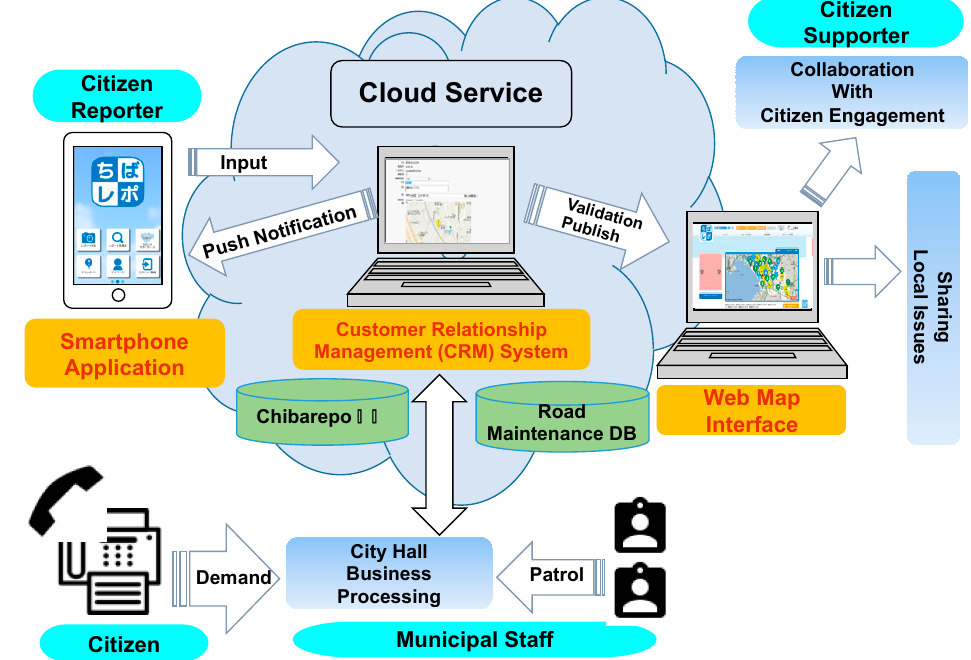
Figure 4. Basic framework of Chiba-repo platform.